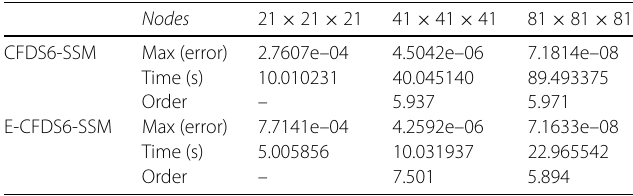
Table 7 The convergence order and computational time for SP 4 at t = 2 Nodes 21 × 21 × 21 41 × 41 × 41 81 × 81 ×